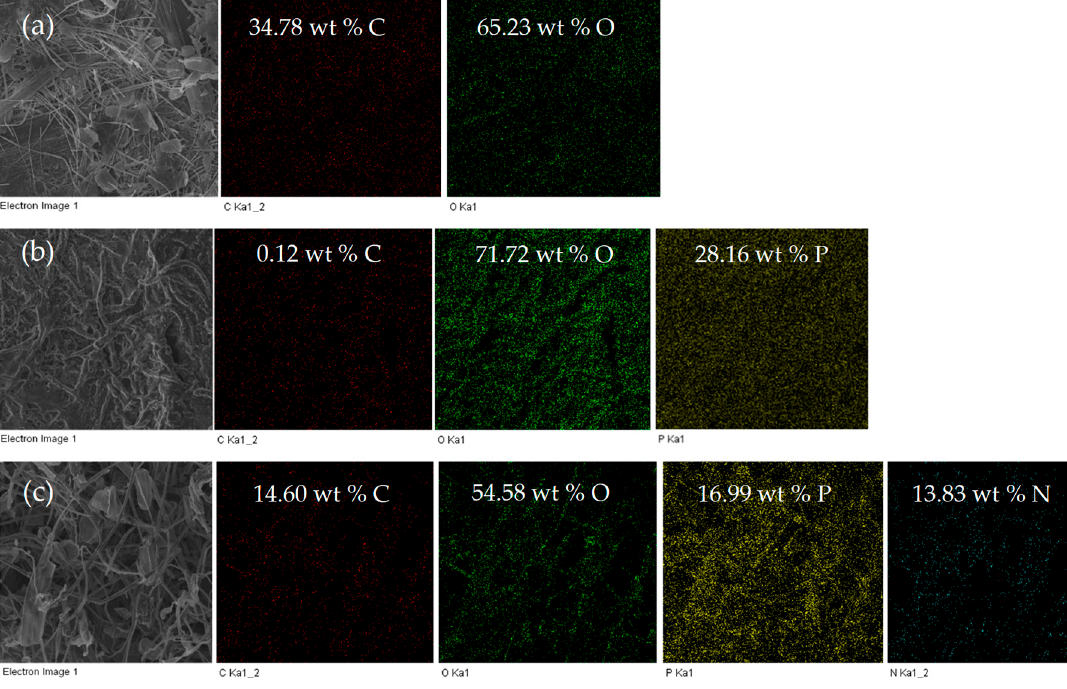
Figure 2. Elemental mappings of ( a ) untreated cellulose, ( b ) P-doped cellulose, and ( c ) P,N-doped cellulose fibrils from SEM-EDS analyses.